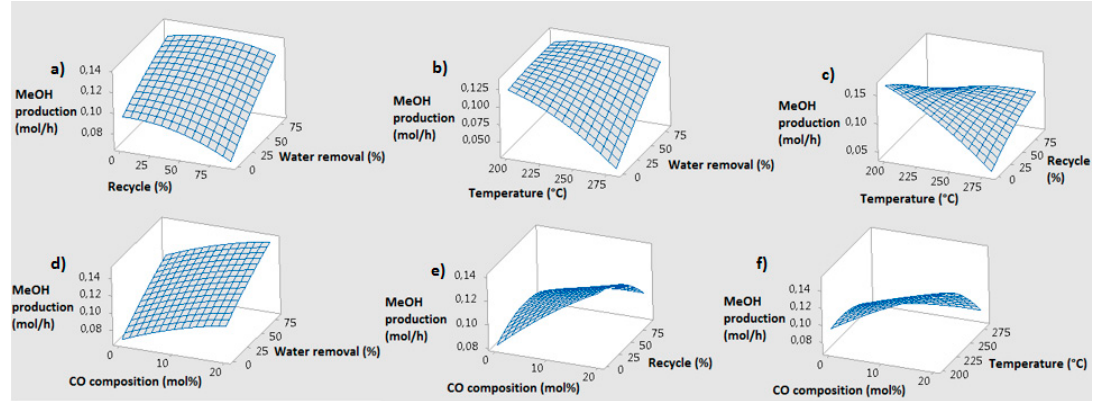
Figure 14. Methanol production surface plots as function of analyzed factors (hold values: recycle 45%, temperature 240 ◦ C, water removal 40%, CO composition in the feed 10 mol%): ( a ) methanol production as function of recycle and water removal; ( b ) methanol production as function of temperature and water removal; ( c ) methanol production as function of temperature and recycle; ( d ) methanol production as function of CO composition and water removal; ( e ) methanol production as function of CO composition in the feed and recycle; ( f ) methanol production as function of CO composition in the feed and temperature.